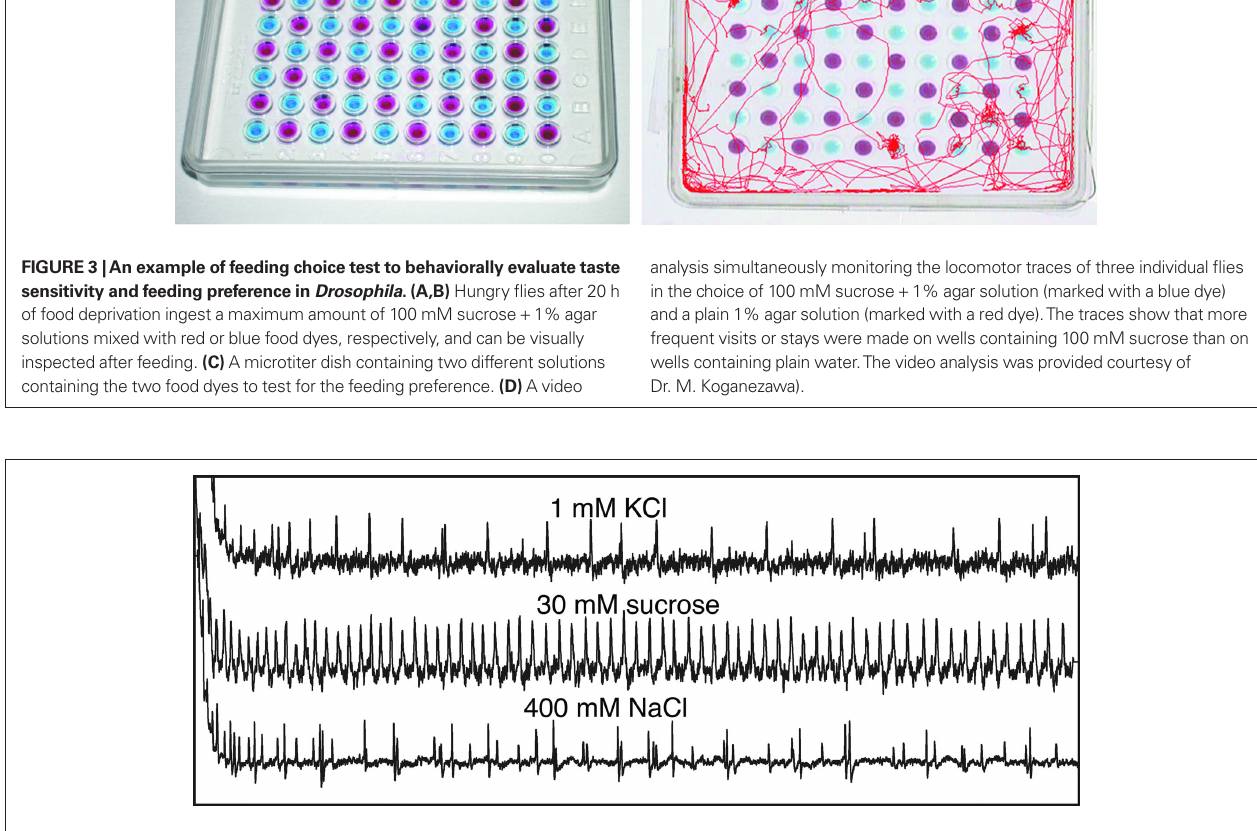
FiGuRe 4 | electrophysiological recordings from a single l -type taste sensillum of the labellum in Drosophila . Different types of neurons are activated by different taste stimulations. See explanations in the text. Recordings provided courtesy of Dr. N.